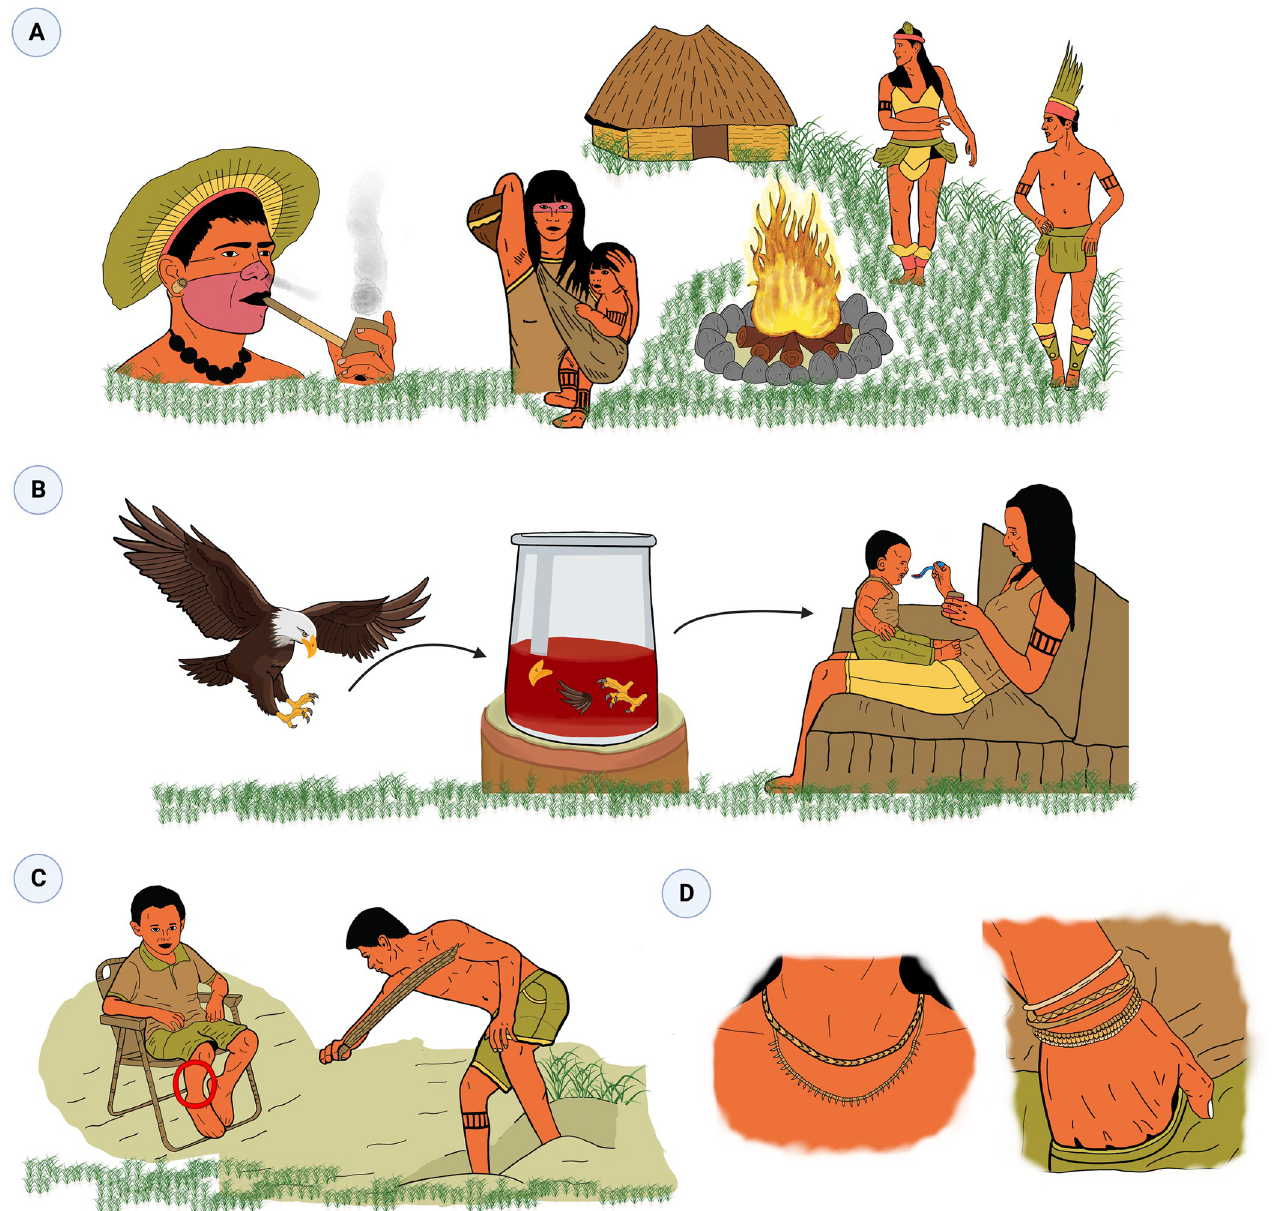
Fig 3. Ritual performed by indigenous villagers of the Alto Solim õ es River area, western Brazilian Amazonia, for protection from snakebites. A) Prayers, chants and smoking. Prayers and chants were widely cited by the indigenous caregivers as viable forms of protection, and can be done by anyone before entering the forest. “ During collective prayer rituals , snakes will reunite to know what is happening in the ritual , and understand that the people will be protected (Participant 3).” However, if the villagers use prayers and songs as a joke, they will be harmed. Rituals of protection may also include smoke from the burning of dried tobacco or garlic leaves, and bee and wasp hives. In this technique, with prayers, chants and smoking, people and environments are protected against all illnesses, including SBEs. The procedure must be repeated by the indigenous caregiver from time to time to renew the protection. B) Rituals of ‘acau ã ’, the snake-eater falcon. The laughing falcon, also called snake hawk ( acauã or águia-cobreiro , in Portuguese Herpetotheres cachinnans L.), is known for its characteristic song (changing from a joyful to a sad sound) and for feeding on snakes. Participant 4 explained this ritual. At the new moon, one of these falcons is killed, and its feathers, beak and talons are removed, burned and used to make an infusion. A spoonful of this infusion is given to a newborn baby. This baby will grow up protected from snakebites as will acquire the look of a falcon. As falcons have excellent vision for capturing snakes in the wild during a flight, snakes will not be able to resist the falcon’s gaze, and will be chased away. The imitation of the falcon song by the indigenous people and chants about these snake predators are also used for protection, for yourself and for a loved one who is going to go into the forest. The falcons are recruited to take care of this person. C) Blessings of the legs using snake simulacrums. Some vines and bush stems have features reminiscent of snake skin. These simulacrums are used to beat the legs of individuals, especially children, who are going to start carrying out activities in the forest. This blessing promotes the protection of this child